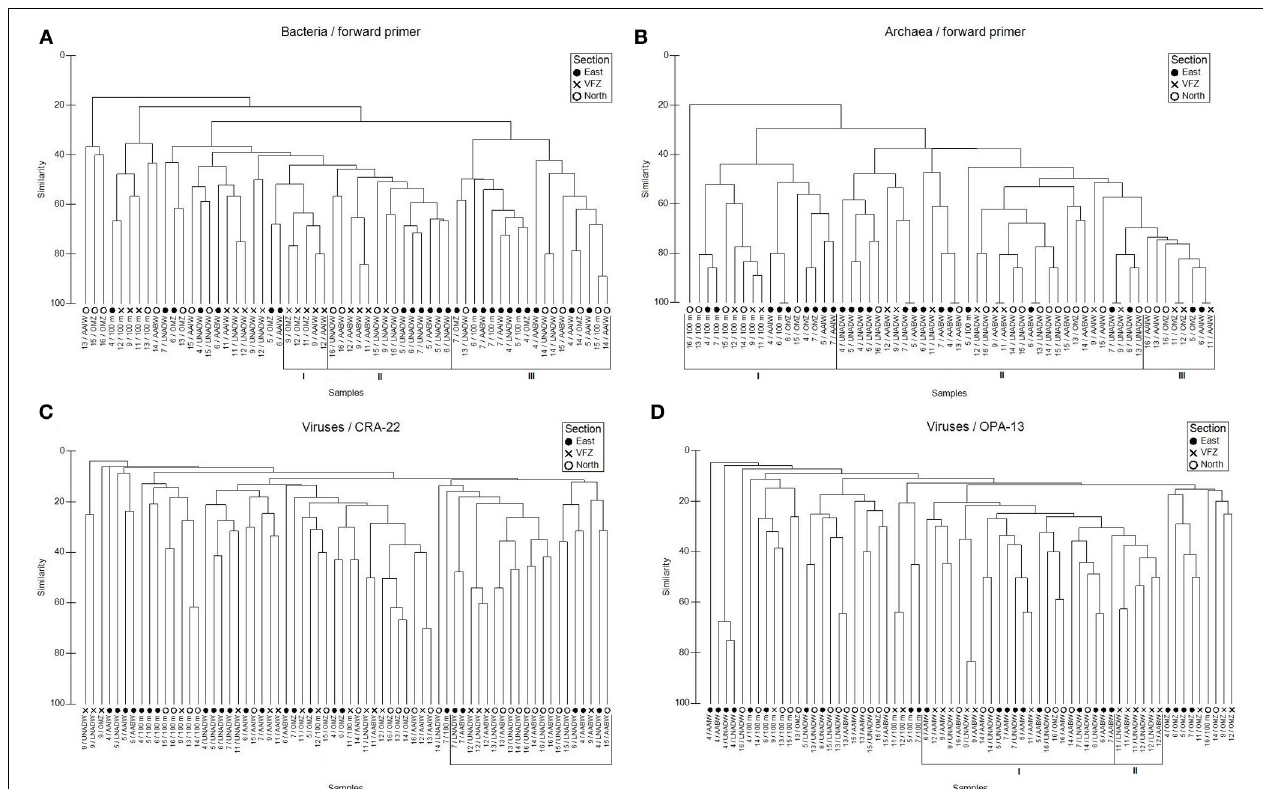
FIGURE 3 | Jaccard clustering analyses of bacterial (A), archaeal (B), and viral (C,D) communities sampled in different water masses north, within and east of the Vema Fracture Zone (VFZ), obtained by T-RFLP (using forward primers) and RAPD-PCR fingerprints. Abbreviations: 100m,